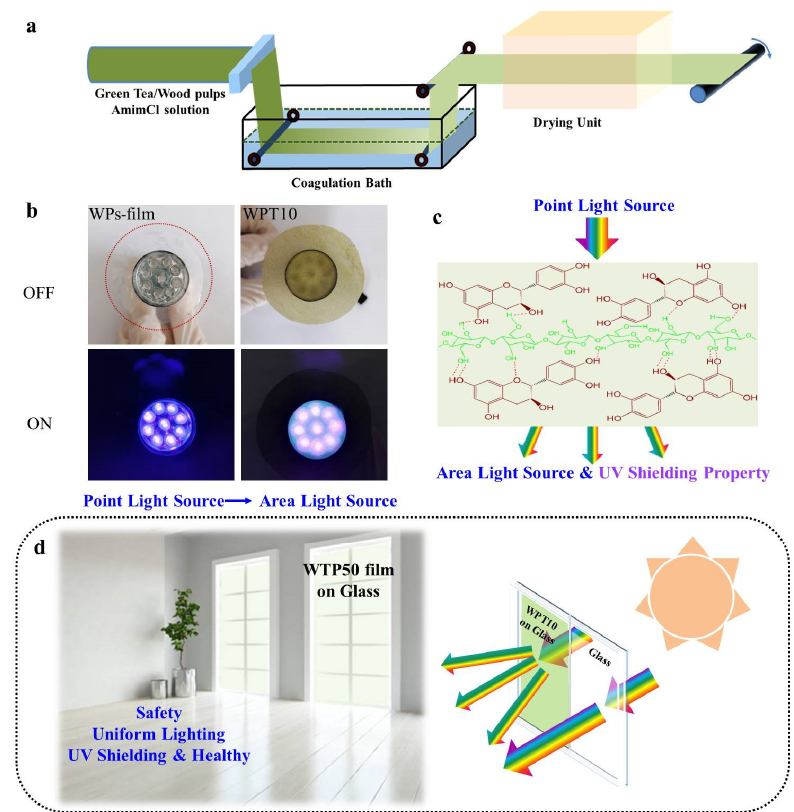
Figure 4. ( a ) A scheme of continuous production line of the green-tea-based all-biomass light-management films. ( b ) Application of the WPs-film and green-tea-based all-biomass composite films on a LED display device. ( c ) The UV-shielding mechanism of the green-tea-based all-biomass composite films. ( d ) The schematic scene of the green-tea-based all-biomass composite films attached to the glass door for the energy-saving buildings.